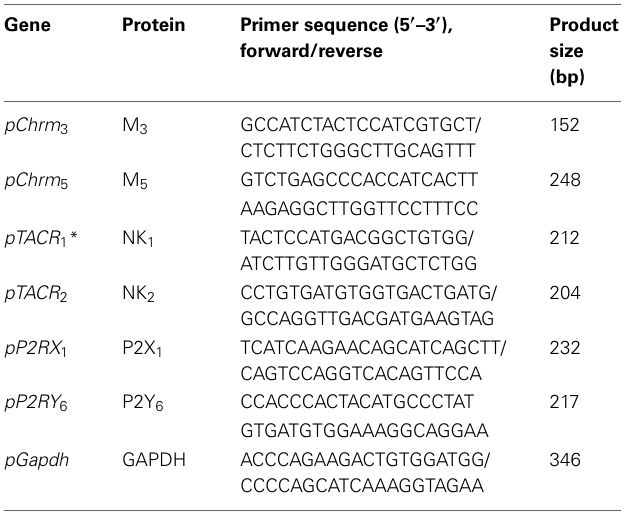
Table 1 | Oligonucleotide primers used in the real-time PCR studies. Gene Protein Primer sequence (5 (cid:2) –3 (cid:2) ), forward/reverse